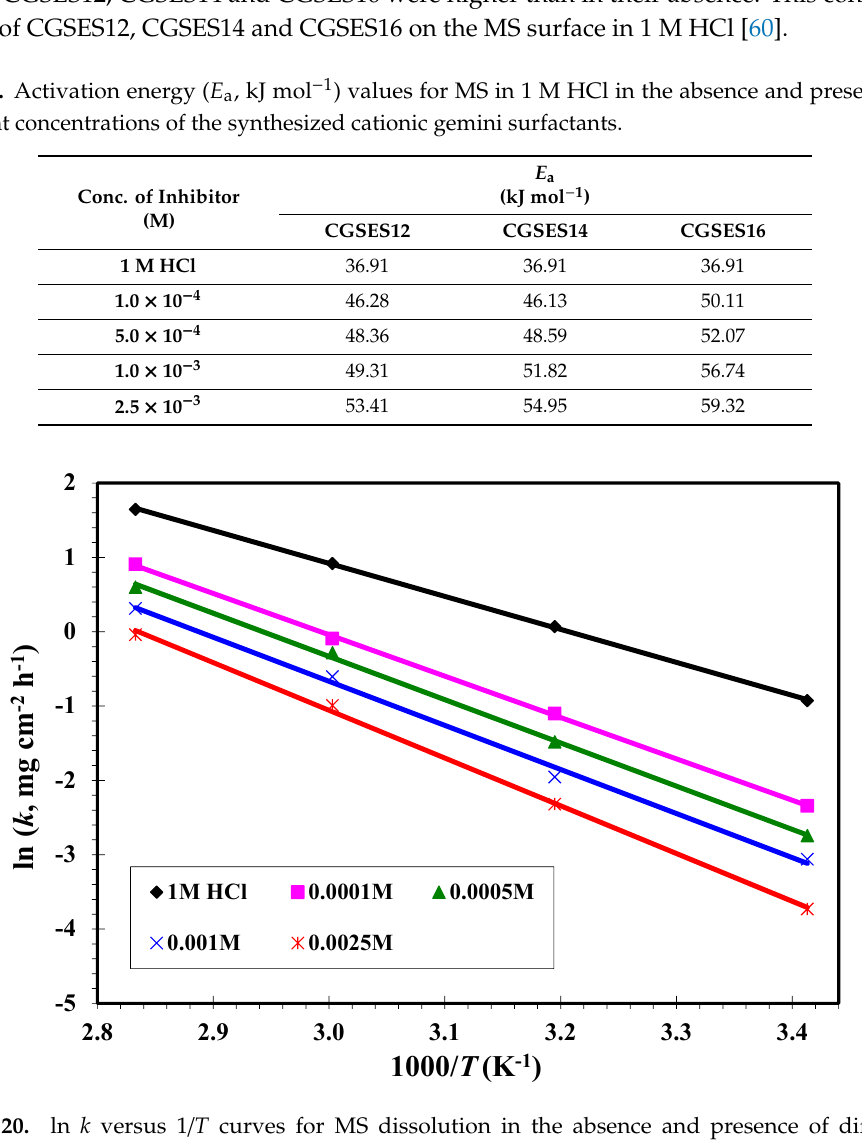
Figure 21. ln k versus 1/ T curves for MS dissolution in the absence and presence of different concentrations of CGSES14 in 1 M HCl solution.